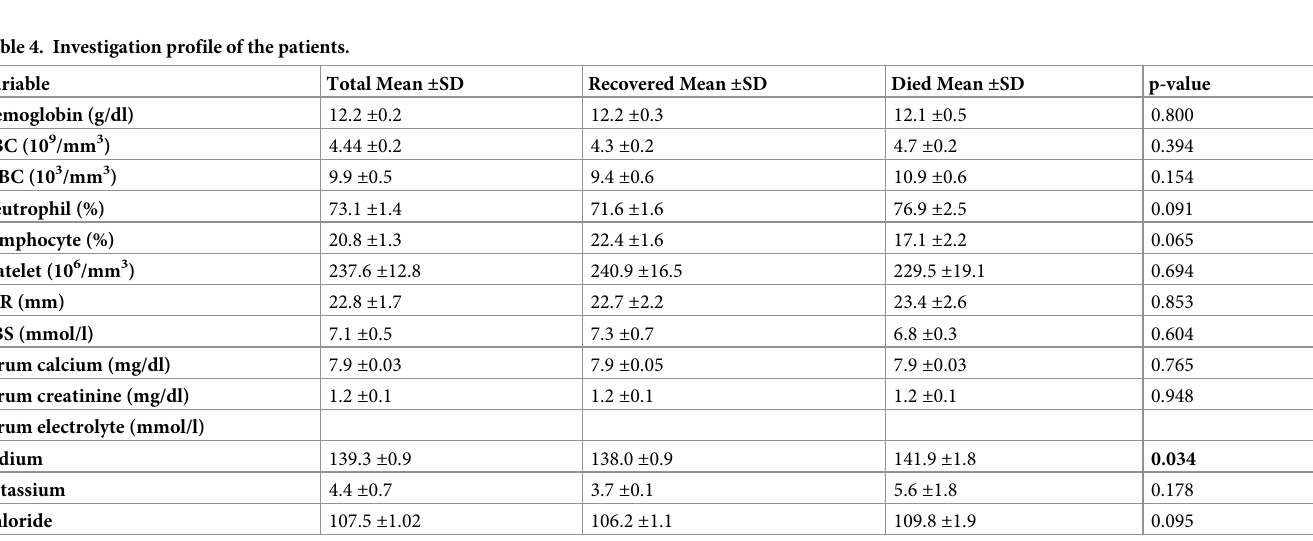
Table 4. Investigation profile of the